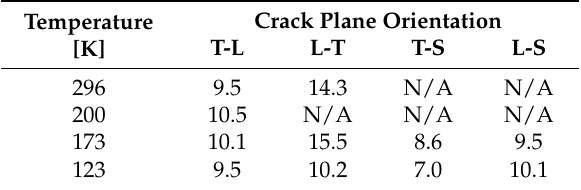
Table 1. Fracture toughness [MPa ∙ m 1/2 ] as a function of temperature and orientation (L: longitudinal or rolling direction, T: transverse direction, and S: thickness of the sheet) [4].